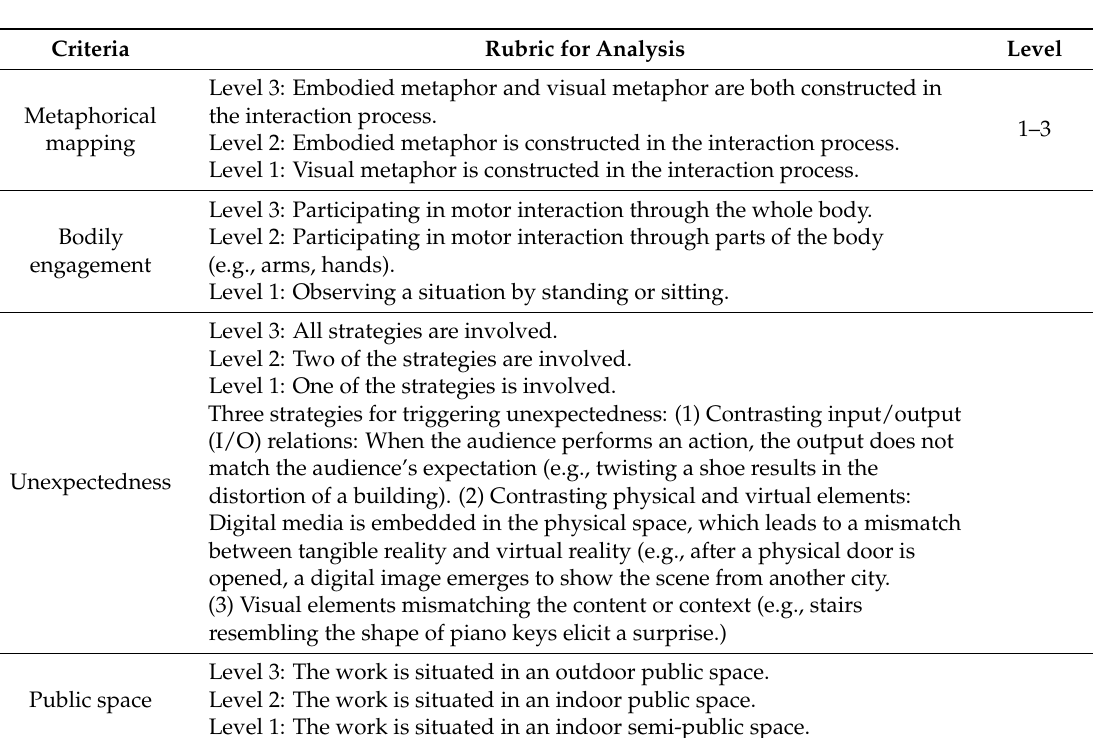
Table 2. Analysis